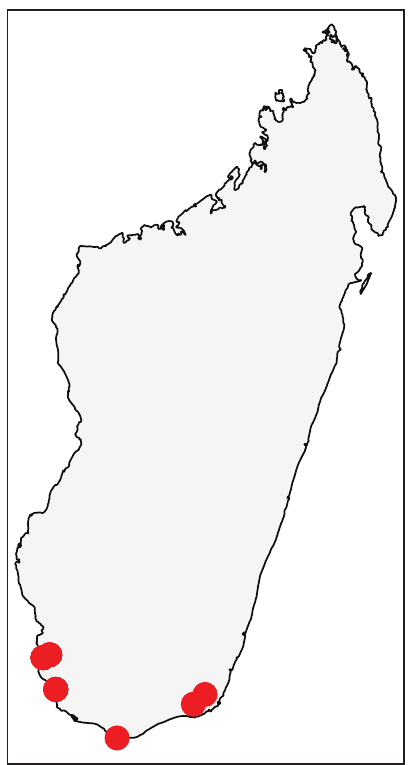
Figures 21. Geographic distribution of Nesomyrmex cingulatus sp. n.. The known localities of N. cingulatus sp. n. in Madagascar.